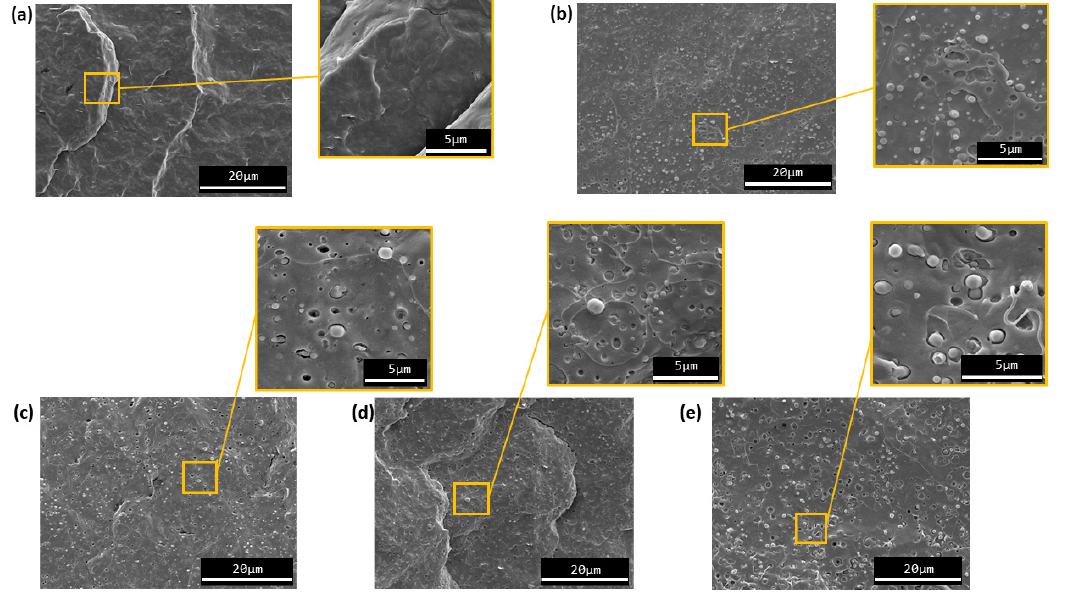
Figure 9. SEM micrographs of ( a ) Neat PHB, ( b ) PHB15, ( c ) PHB15-Joncryl ® , ( d ) PHB15-TGIC, and ( e ) PHB15-polyHMDI.